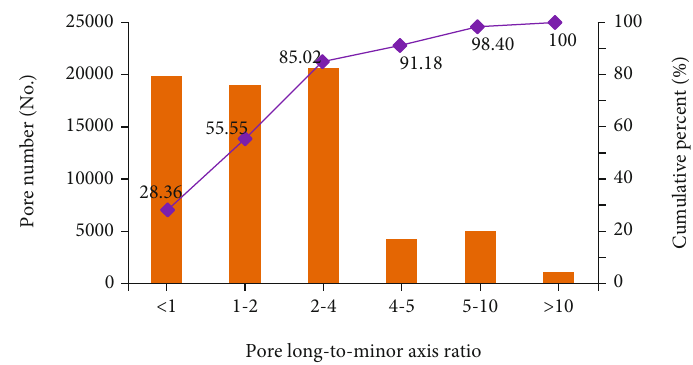
Figure 16: Characteristics of the aspect ratio of the organic pores based on 3D FIB-SEM data.